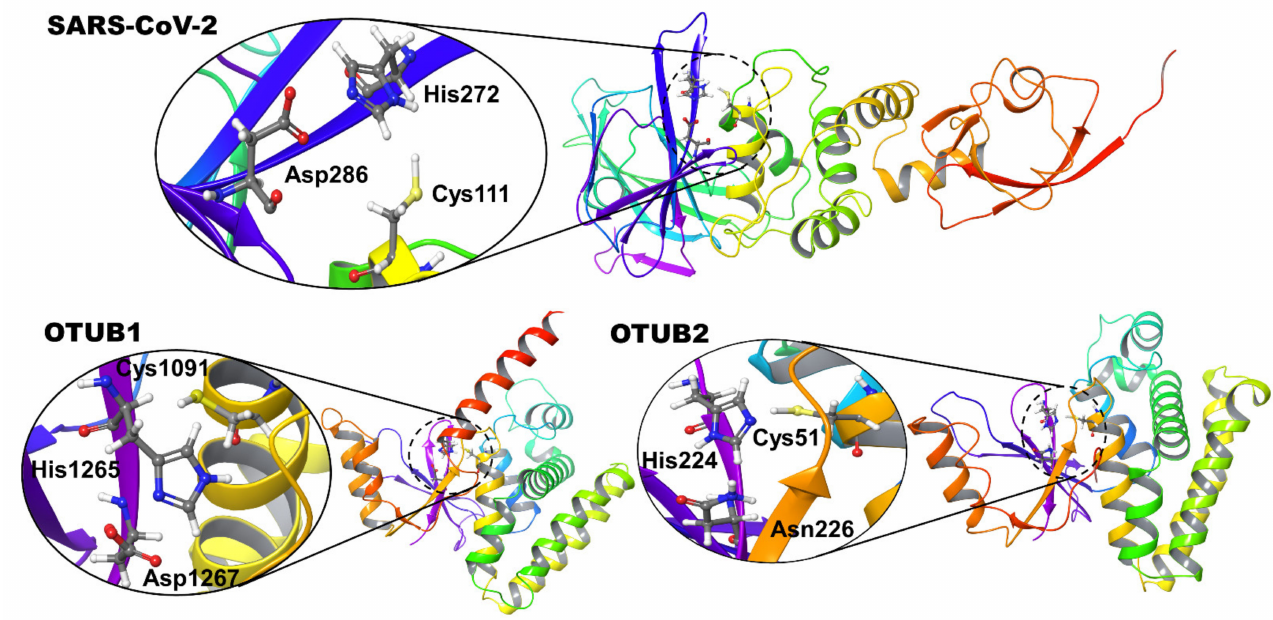
Figure 1. Structural details of the deubiquitinase-like arrangement of active site residues of SARS-CoV-2 PLpro and OTUs. The catalytic triads made up of Cys-His-Asp/Asn residues are shown as insets.